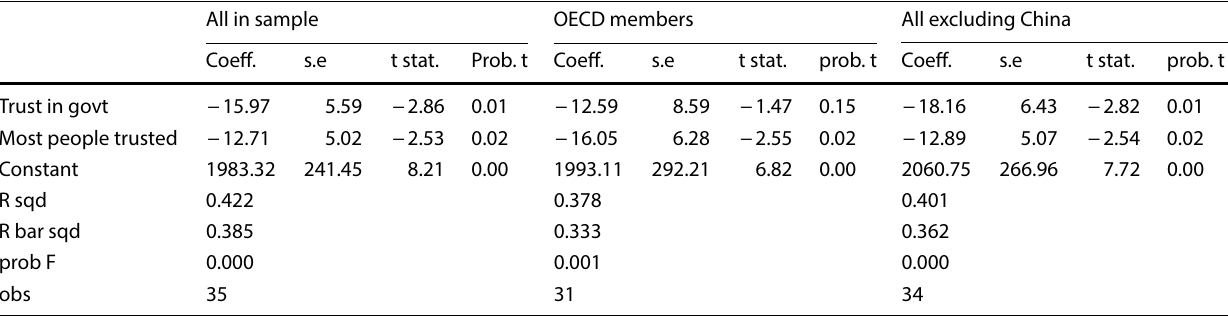
Table 8 Regression results for period 2